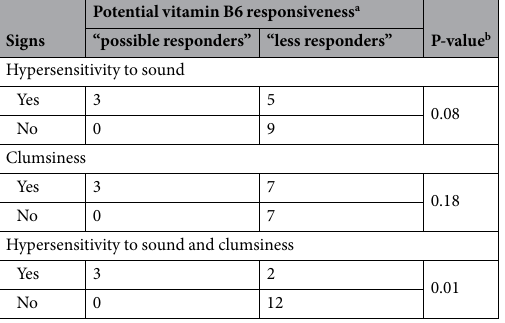
Table 2. Number of participants according to signs and potential vitamin B6 responsiveness. a According to the Clinical Global Impression-Improvement scale. b Fisher’s exact test.